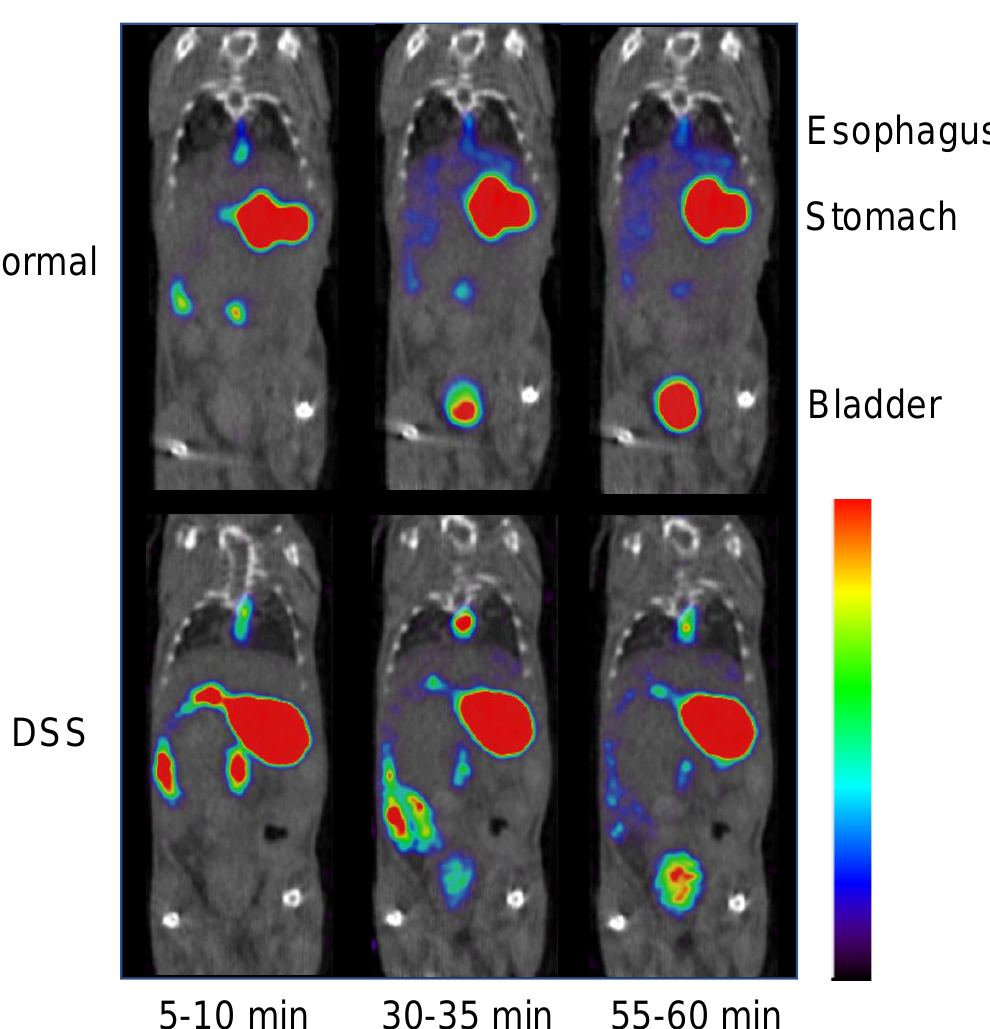
Figure 2. Representative [ 123 I]MIBG single-photon emission computed tomography (SPECT) imaging in normal and dextran sodium sulfate (DSS)−induced experimental colitis mice at 5–10 min, 30–35 min, and 60–65 min after oral administration of approximately 20 MBq of [ 123 I]MIBG. DSS-induced experimental colitis mice show decreased accumulation of [ 123 I]MIBG in the bladder at 30–35 min and 60–65 min after oral [ 123 I]MIBG administration and increased accumulation in the small intestine at 5–10 min and 30–35 min after oral [ 123 I]MIBG administration. Time-activity curves generated from the SPECT images of control and DSS-induced experimental colitis mice orally injected with [ 123 I]MIBG is shown in Figure 3. In DSS-in- duced experimental colitis mice, accumulation of [ 123 I]MIBG was significantly lower in the heart, liver, and bladder compared with normal mice, whereas [ 123 I]MIBG accumulation was higher in the stomach at the early time points after oral administration.